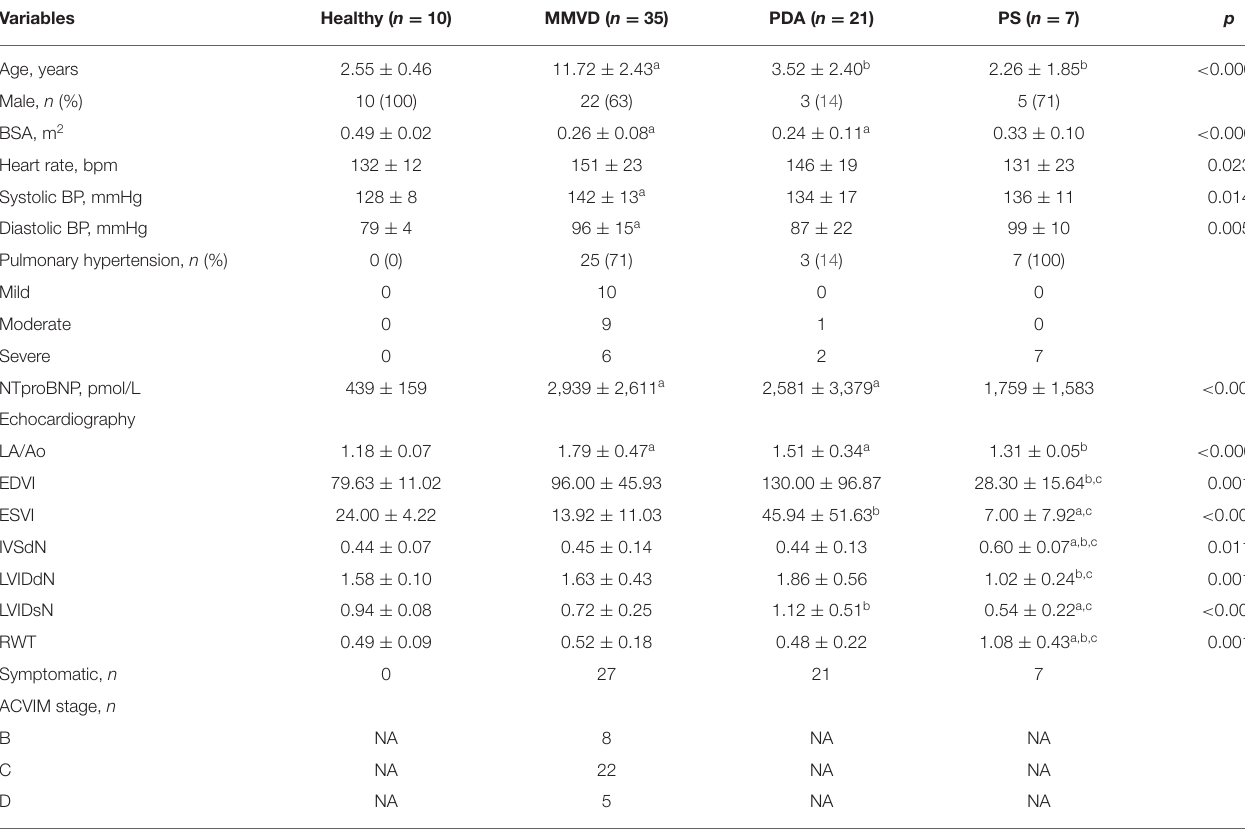
TABLE 1 | Clinical characteristics of dogs included in the classification by disease type. Variables